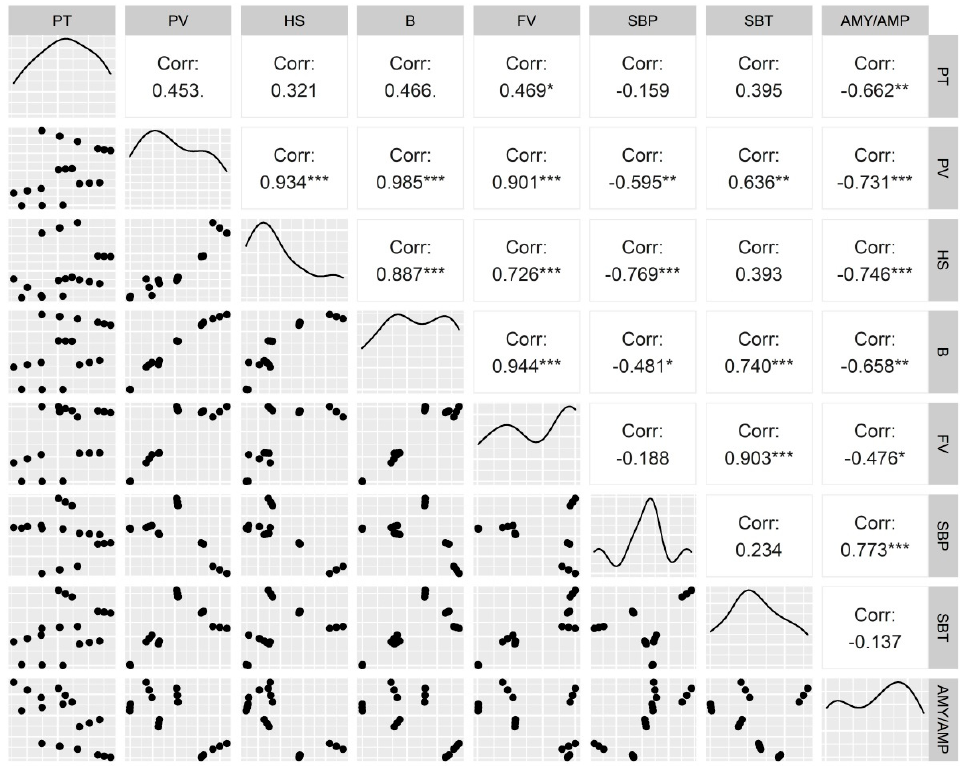
Figure 8. Correlation between the flour rheological properties and amylose to amylopectin ratio of wheat genotypes grown under control and HNT conditions. (PT—pasting temperature; PV—peak viscosity; HS—holding strength; B—breakdown; FV—final viscosity; SBP—setback from peak; SBT—setback from trough; AMY/AMP—amylose to amylopectin ratio). * Significantly different at p < 0.05; ** significantly different at p < 0.01; *** significantly different at p < 0.001.